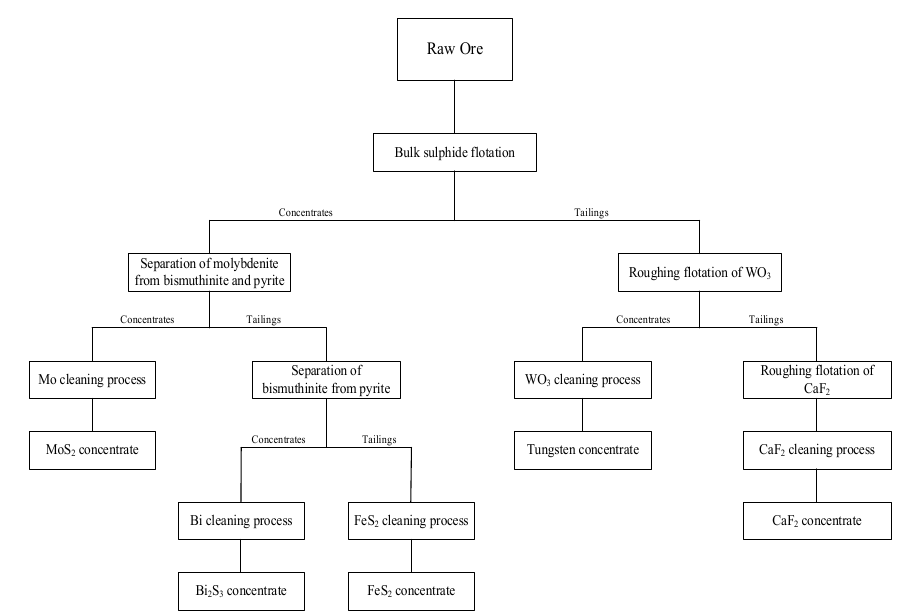
Figure 1. The flotation flowsheet of the Shizhuyuan ore in Dongpo dressing plant.